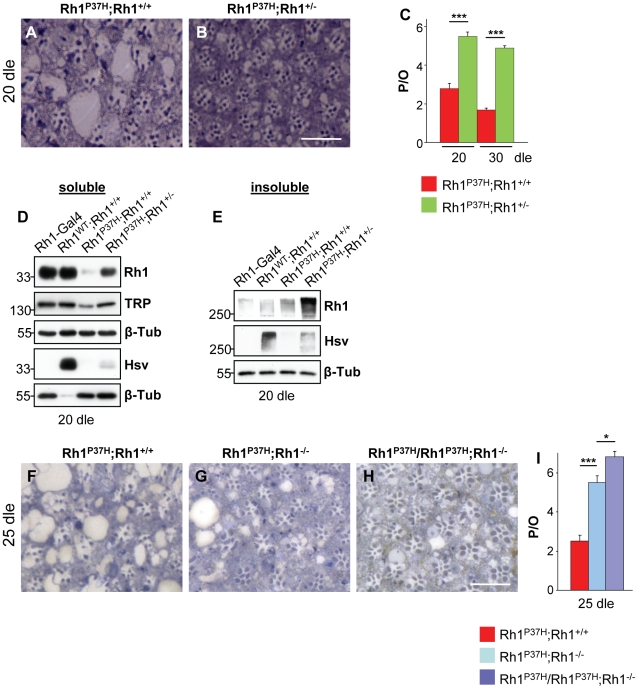
The endogenous Rh1 is required for Rh1P37H toxicity.(A–C,F–I) Reducing the dosage of endogenous Rh1 rescues retinal degeneration in Rh1P37H;Rh1+/+ flies, suggesting that endogenous Rh1 is required for Rh1P37H toxicity. Photomicrographs of toluidine blue sections of Rh1P37H;Rh1+/+ (A,F), Rh1P37H;Rh1+/−(B), Rh1P37H;Rh1−/− (G) and Rh1P37H/Rh1P37H;Rh1−/− (H) flies at 20 dle (A,B) and 25 dle (F–H) and (C,I) quantification of the average number of P/O (n>7 animals/group, * p<0.05 and *** p<0.001 t-test). Scale bar is 50 µm. (D,E) Immunoblots showing the levels of total and ectopic mature (D) and aggregated Rh1 (E), as well as TRP levels in flies of indicated genotypes, after 20 dle. β-Tubulin (β-Tub) served as loading control. Overexpressed WT or P37H Rh1 was hsv-tagged and Rh1-Gal4 flies, lacking hsv, served as negative control for the hsv antibody Please note that 10-fold less protein (D) was loaded for Rh1WT;Rh1+/+ flies for the hsv WB.